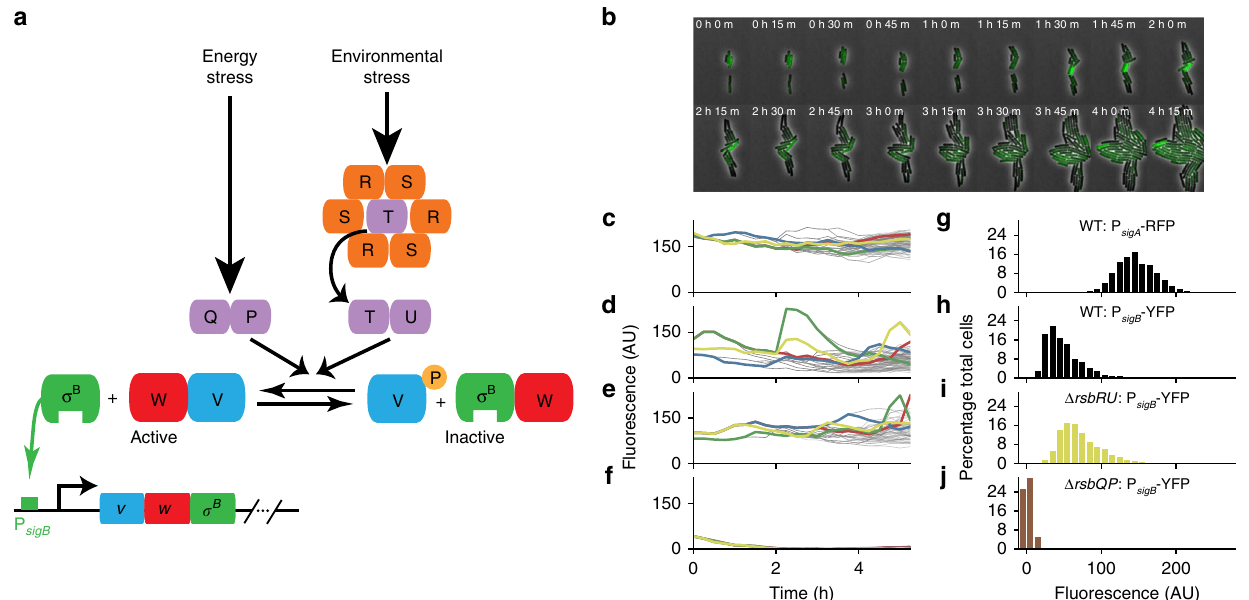
Fig. 1 σ B pulses in B. subtilis microcolonies via the energy stress pathway under bio fi lm conditions. a Network diagram of σ B circuit. Energy stress causes the complex RsbQP (QP, purple) to dephosphorylate RsbV (V, blue). Environmental stress releases RsbT (T, purple) from the stressosome (consisting of RsbR (R, orange) and RsbS (S, orange) subunits). RsbT then binds RsbU (U, purple) and activates it, with active RsbU dephosphorylating RsbV. Dephosphorylated RsbV (V, blue) binds to RsbW (W, red), releasing σ B ( σ B , green) to bind to RNA polymerase and activate its target genes, including its own operon. b Filmstrip of σ B activation in a WT B. subtilis microcolony grown in bio fi lm promoting medium. Heterogeneous expression levels of P sigB -YFP (green) re fl ect pulsing activity. Numbers indicate time in hours and minutes. c Single cell fl uorescence values for constitutive fl uorescent reporter (P sigA - RFP) over time (representative traces). d – f Single cell fl uorescence values for P sigB -YFP reporter over time for WT d , Δ rsbRU e , and Δ rsbQP f , strains. The time in hours is relative to the start of analysis. g , h Histograms of fl uorescence intensities of WT cells for the constitutive reporter P sigA -RFP g and P sigB - YFP reporter h (For both, cells: 1157, movies: 6, experiments 2). i , j Histograms of P sigB -YFP expression for Δ rsbRU strain i (cells: 1178, movies: 5, experiments: 3) and Δ rsbQP strain j (cells: 1290, movies: 8, experiments 3). Histograms in g – j include all frames in movies with more than 8 cells. Source data are provided as a Source Data fi